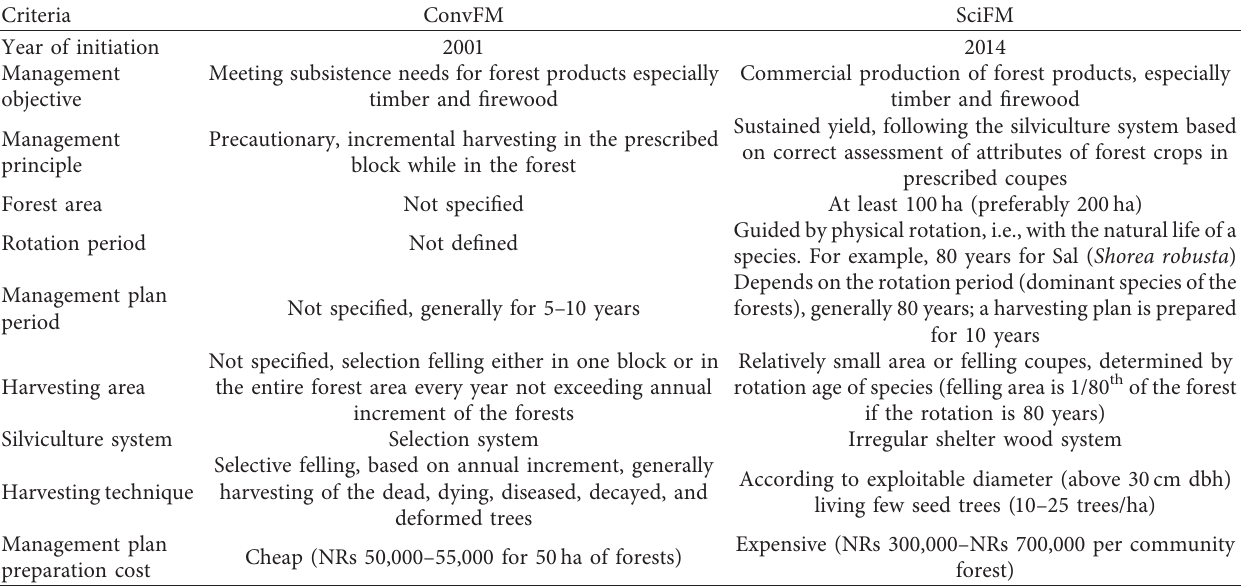
Table 1: Comparison of two forest management systems.